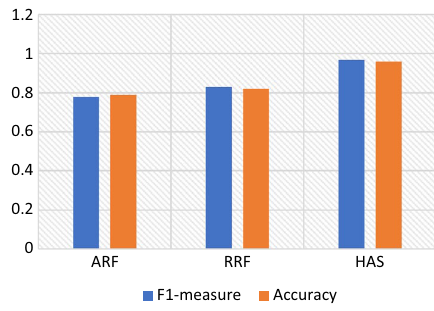
Fig. 4 F1-measure and accuracy assessment of the proposed feature extraction methodologies using LSTM